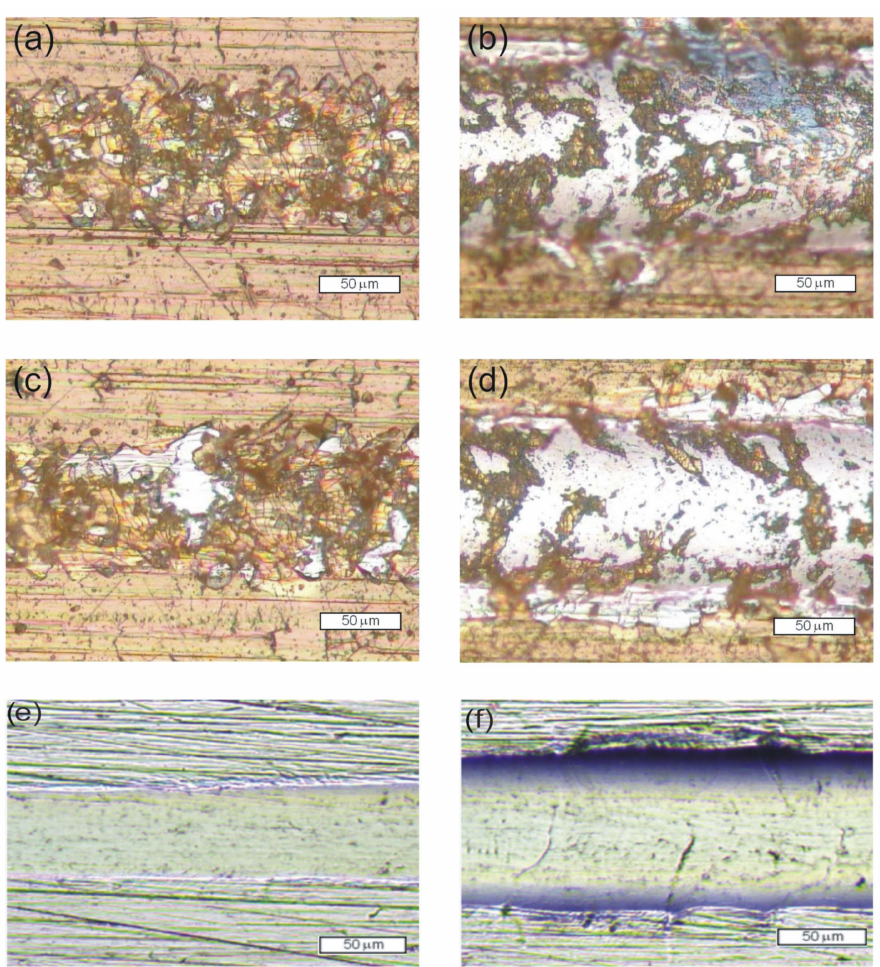
Figure 5. Images of the scratch track at locations where a characteristic damage of the layer occurred: ( a ) SiC x N y :H at L C1 = 3.4 N, ( b ) SiC x N y :H at L C2 = 8.9 N, ( c ) N + /SiC x N y :H at L C1 = 2.9 N and ( d ) N + /SiC x N y :H at L C2 = 7.3 N, ( e ) unmodified Crofer 22APU steel at 3 N, ( f ) unmodified Crofer 22APU steel at 8